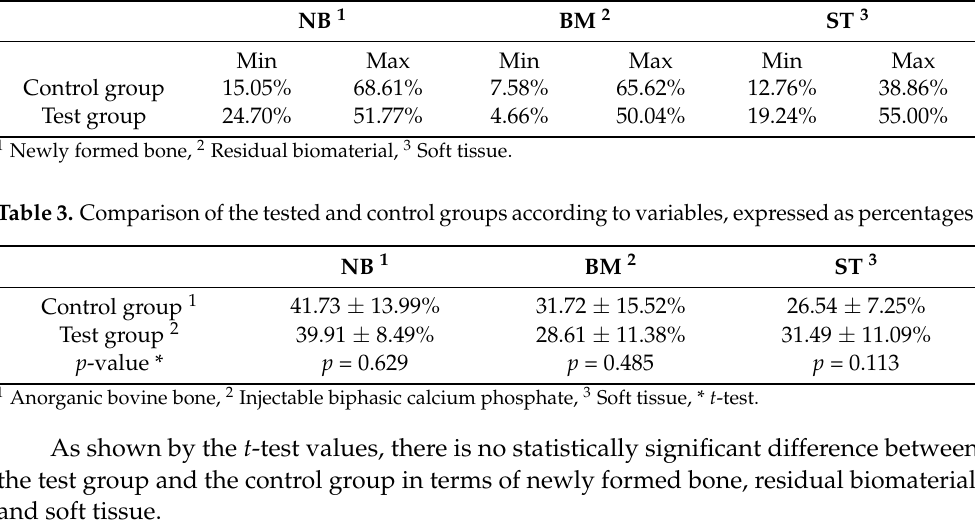
Table 2. Minimum and maximum values of newly formed bone, residual biomaterial, and soft tissue between the control and test groups, expressed in percentages.